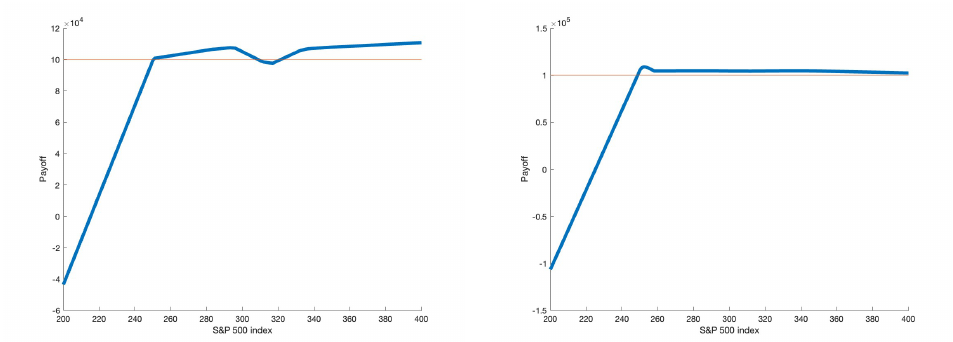
Figure 7. The payoffs of the optimized portfolios obtained with ν = 0.1 ( left ) and ν = 0.00001 ( right